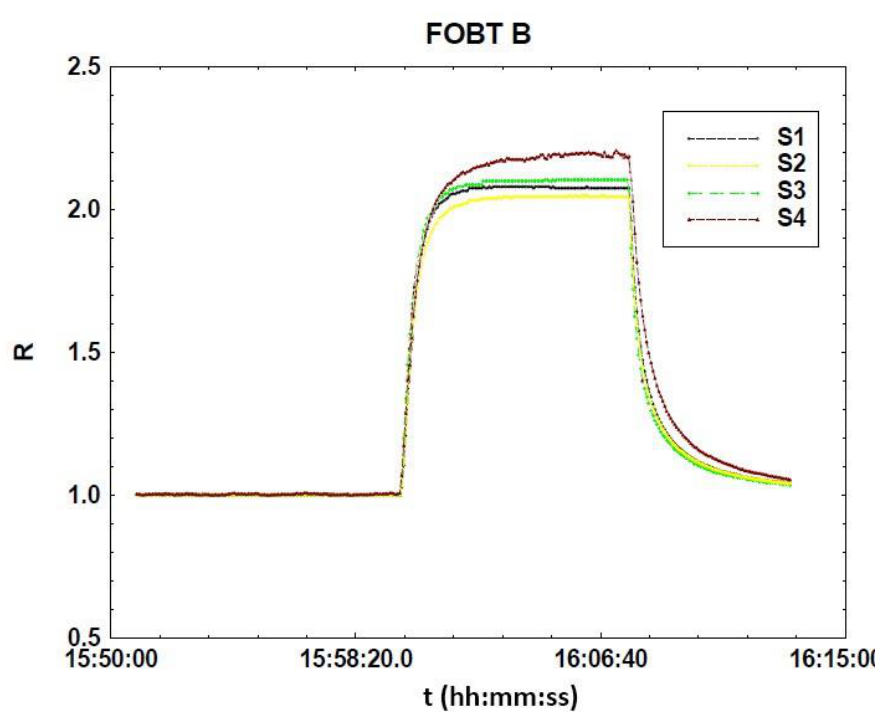
Figure 8. Normalized dynamic responses of SmFeO 3 sensors vs. FOBT B exhalation, at a working temperature of 350 °C.